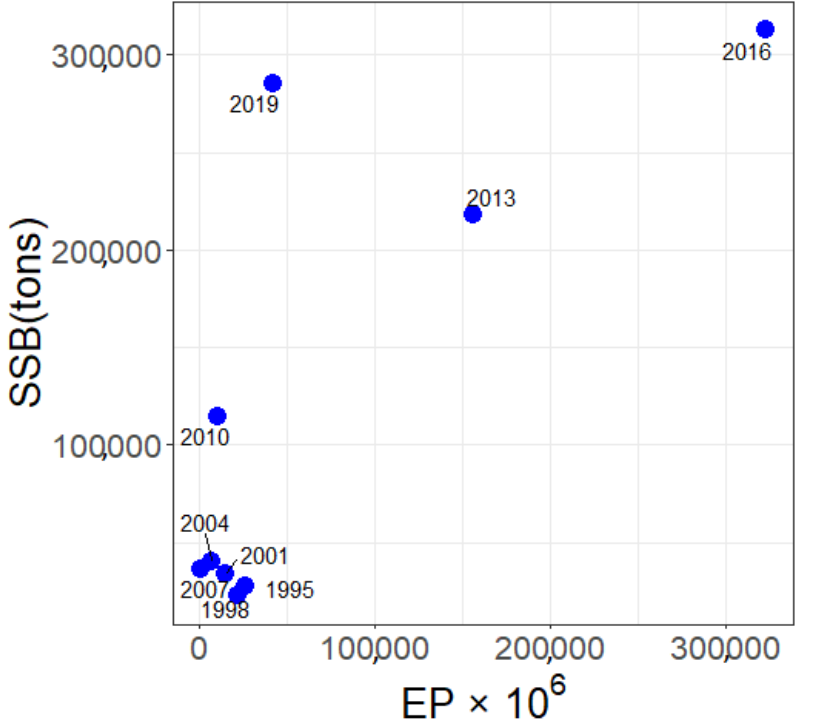
Figure 2. Graphic representation of hake eggs production (EP) estimated for the subarea 8abd and northern hake stock spawning biomass from WGBIE in subareas 4, 6, and 7, and in divisions 3a, 8a– b, and 8d [37].